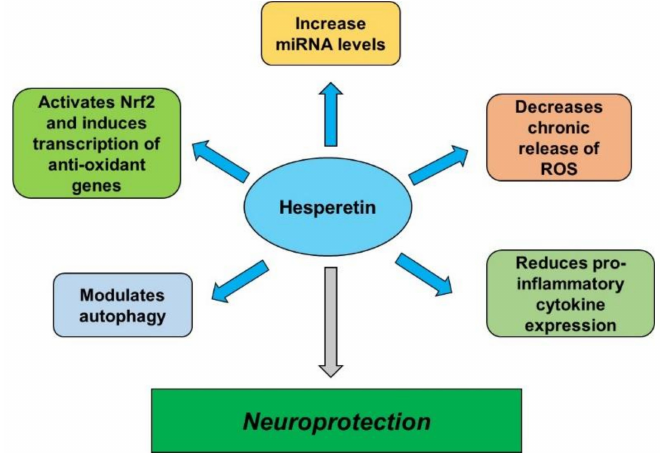
Figure 7. Hesperetin’s neuroprotective effects. Studies show that in vivo and in vitro administration of hesperetin increases miRNA levels, decreases the expression of proinflammatory cytokines, reduces autophagy, and reduces the chronic production of ROS, indicating a neuroprotective mechanism for this compound. miRNA,